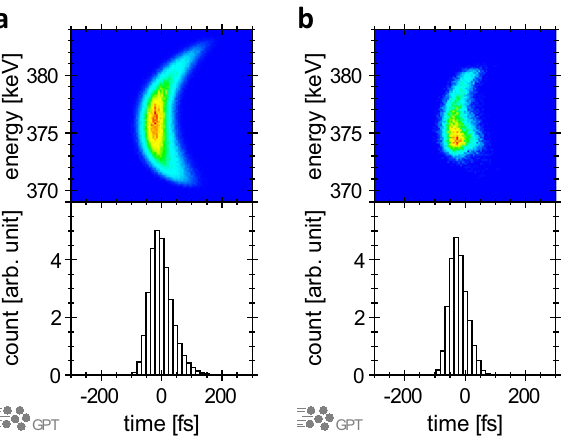
Figure 4. Electron pulse width calculated using the GPT code. ( a , b ) Phase-space distribution at the compression point in the absence ( a ) and presence ( b ) of the 50-μm